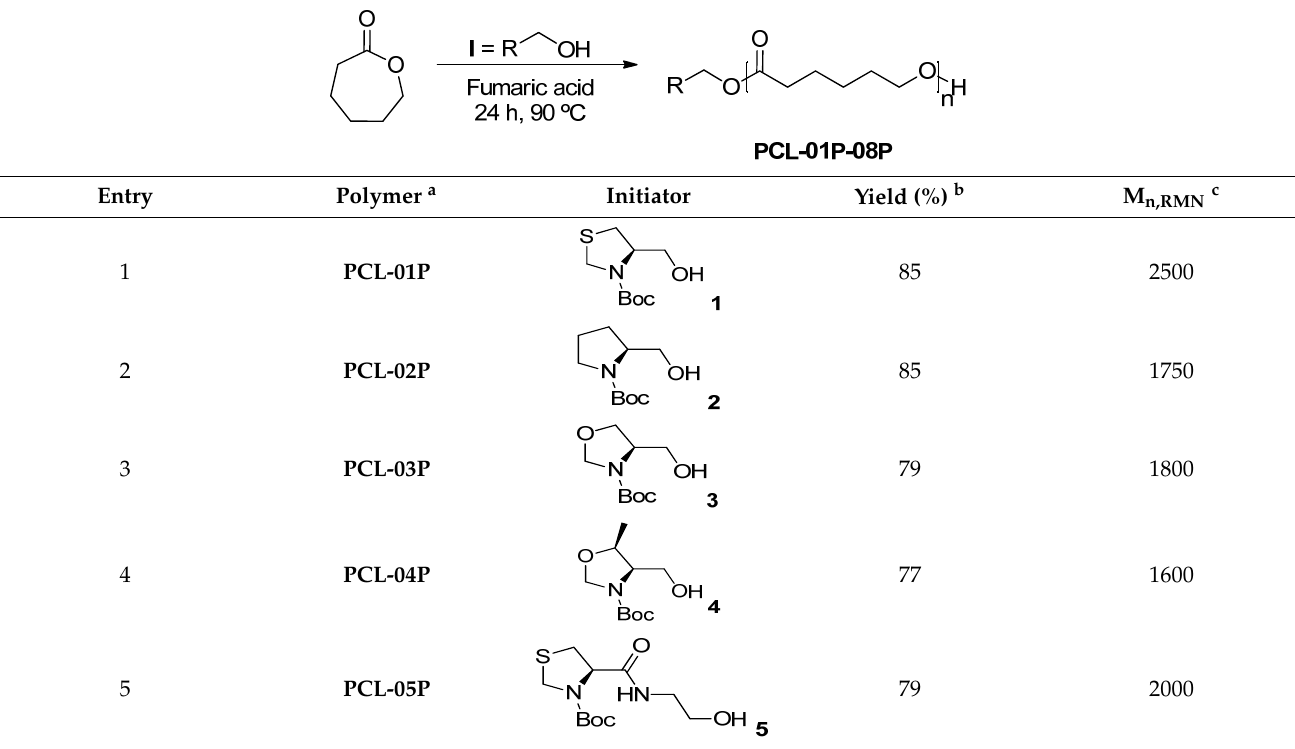
Table 2. Application of the optimized conditions for polymerization of ε -caprolactone initiated by compounds 1 – 8 .